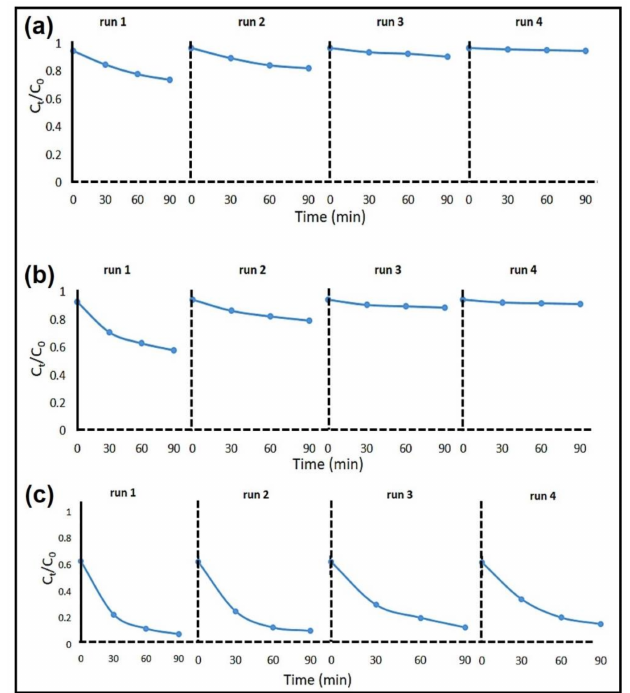
Figure 9. Recycling studies of ( a ) CdS, ( b ) Ag 3 PO 4 , and ( c ) Pt-Ag 3 PO 4 / CdS / chitosan photocatalyst for the photodegradation of MB